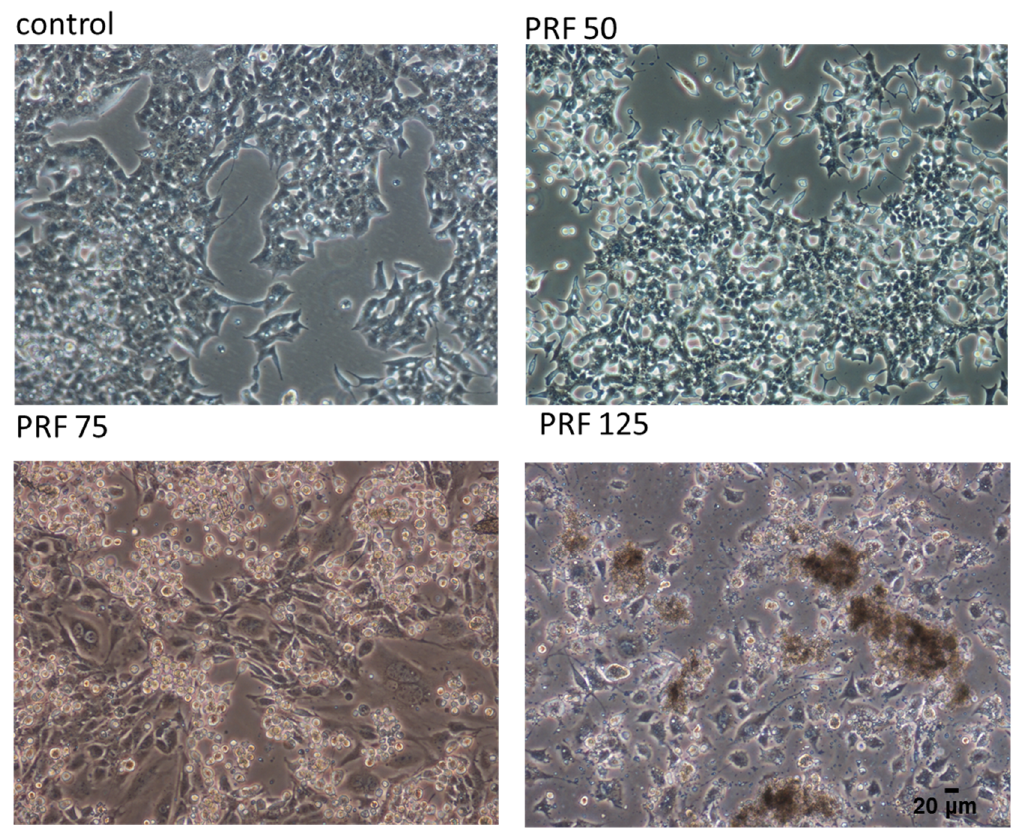
Figure 2. The influence of V. opulus PRF extract on the morphology of MIN6 cells treated for 24 h; control cells were not exposed to any compound but the vehicle; randomly chosen fields were photographed at × 200.